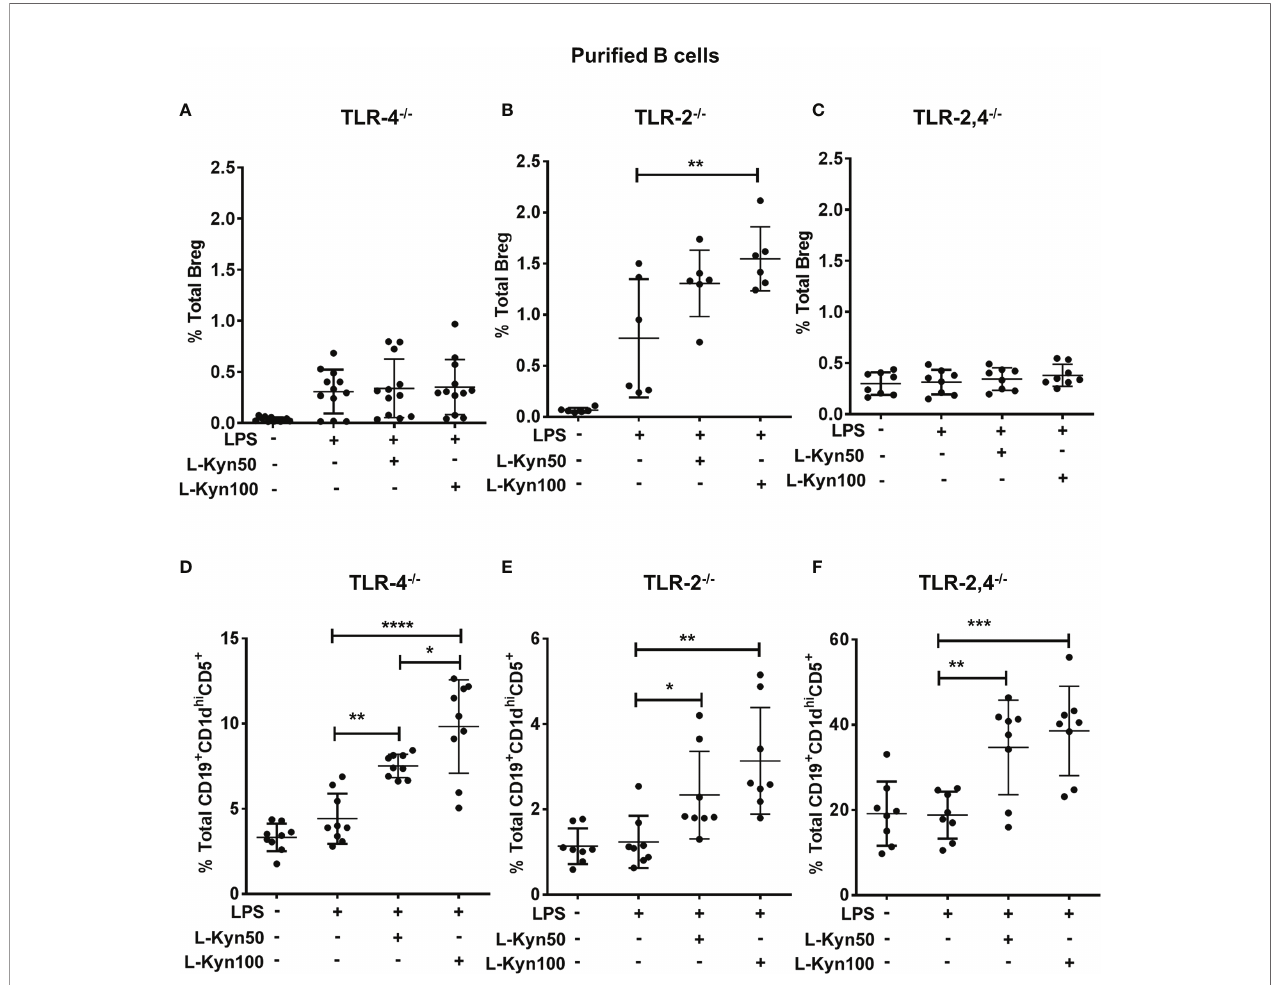
FIGURE 6 | L-Kyn induced Breg differentiation was TLR-4 dependent but TLR-2 independent, the differentiation of Breg precursor was TLR-2 and TLR-4 independent. CD19 + B cells were negatively selected from whole splenocytes of TLR-4 -/- , TLR-2 -/- and TLR-2,4 -/- mice were disaggregated and seeded with LPS (10 m g/ml), and increasing concentrations of L-Kyn (50µM and 100 m M) for 72 hrs. Bregs were identi fi ed as CD19 + CD5 + CD1d hi IL-10 + by fl ow cytometry. (A, C, E) Upper panel- L-Kyn induced Breg differentiation was impaired in B cells of TLR-4 -/- and TLR-2, 4 -/- but induction in TLR-2 -/- following stimulation with LPS+L-Kyn. Data shown here are pooled from four independent experiments with 3 technical replicates in each condition. (B, D, F) Lower panel- L-Kyn promoted Breg precursors (CD19 + CD1d hi CD5 + ) in B cells of TLR-4 -/- TLR-2 -/- and TLR-2, 4 -/- following stimulation with LPS+L-Kyn. Data shown here are pooled from three independent experiments with 3 technical replicates in each condition *p < 0.05, **p < 0.001, ***p < 0.0001, ****p <